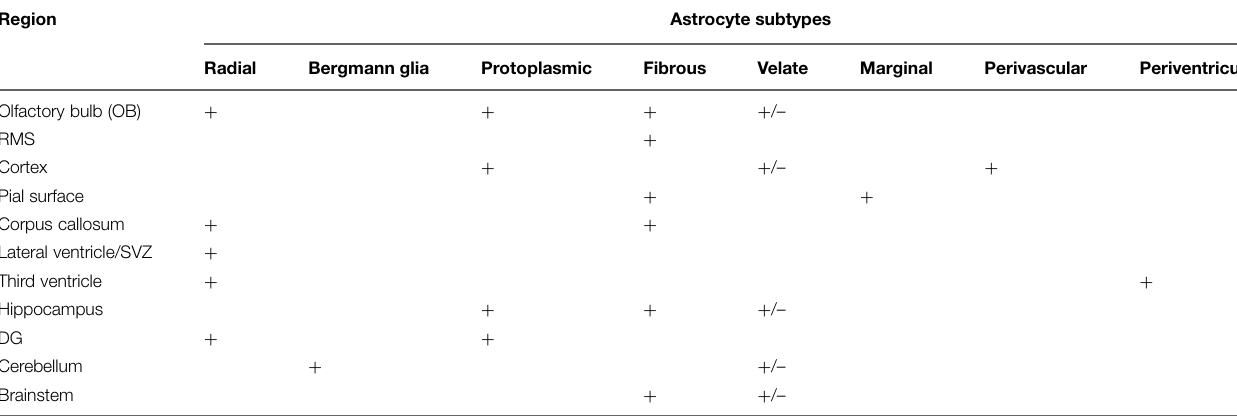
TABLE 1 | Regional heterogeneity of astrocytes in the African giant rats (AGR) brain. Region